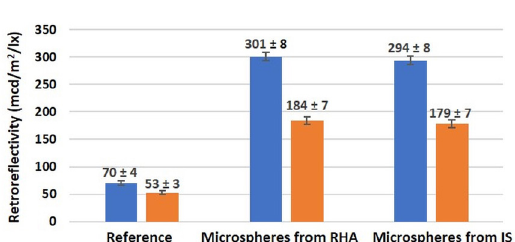
Figure 4. Retroreflectivity measurements for the 15 m (blue) and 30 m (orange) geometries in plates without microspheres, with microspheres from RHA e with microspheres from